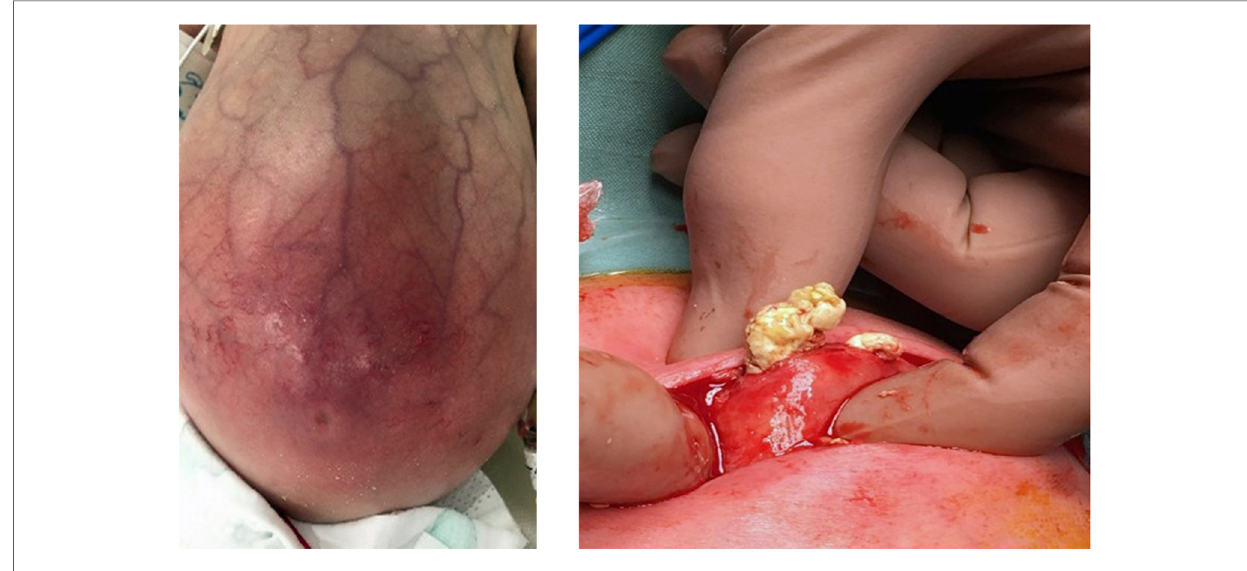
FIGURE 13 Images showing the clinical presentation of the abdomen in milk curd obstruction and the intra-operative fi ndings in the same patient.